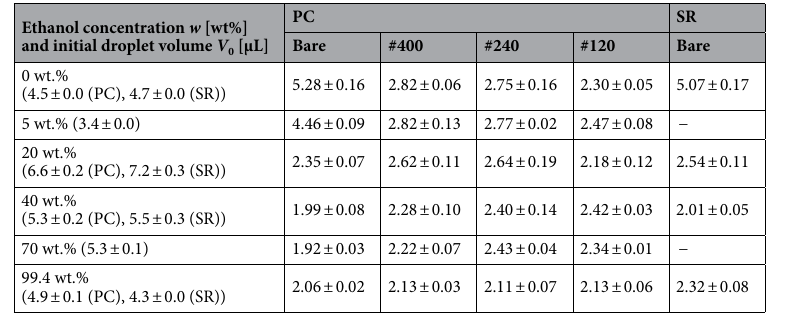
Table 1. Impingement velocity u c [m/s] of each droplet where the splashing occurs on each solid substrate.